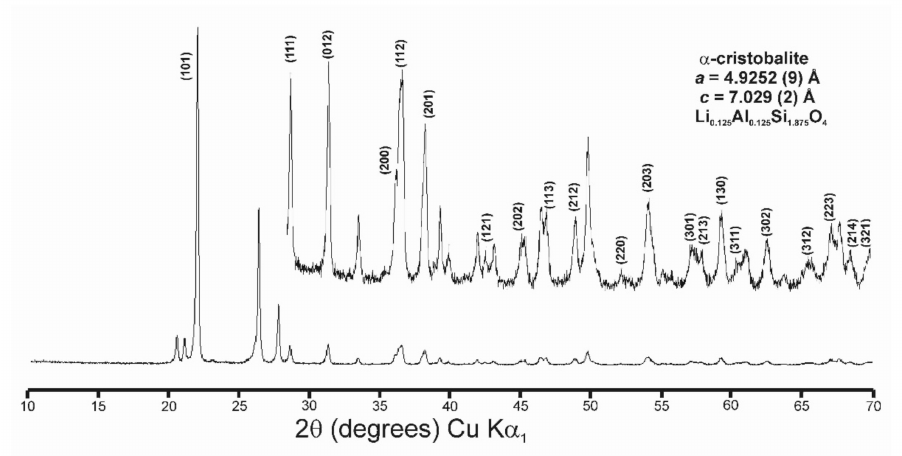
Figure A8. Powder XRD pattern of α -cristobalite Li 0.125 Al 0.125 Si 1.875 O 4 (Si/Al = 15/1) with a = b = 4.9252 (9) Å and c = 7.029 (2) Å, and α = β = γ = 90 ◦ , with (hkl) peaks from the P 4 1 2 1 2 space group symmetry, synthesized at 1200 ◦ C and 1 atm. File 75300 is α -cristobalite in ICSD database, with a = b = 4.9717 (4) Å, c = 6.9223 (3) Å, and α = β = γ = 90 ◦ , which is related to this pattern. The sample was crystallized from the amorphous precursor gel at 1200 ◦ C and 1 atm. Some additional peaks from β -spodumene and β -eucryptite are not marked in the